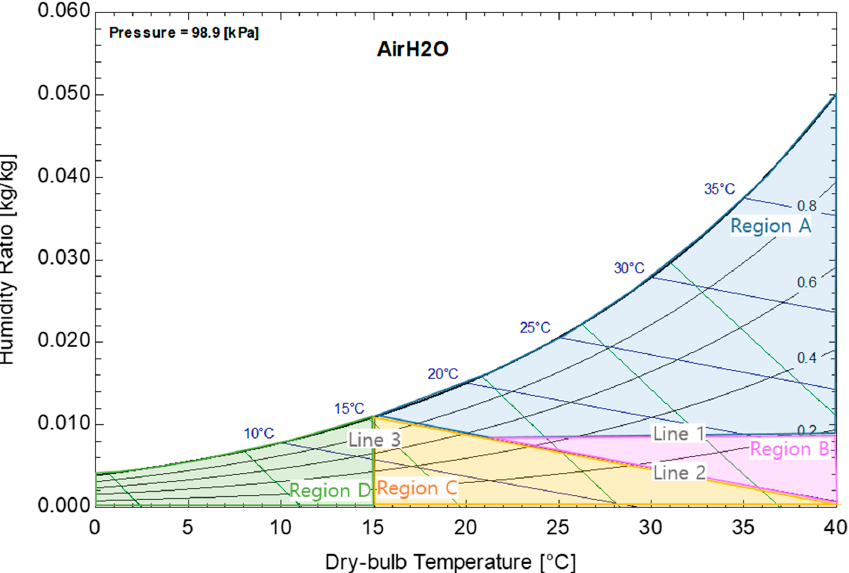
Figure 3. Operation modes of the LDIDECOA on psychometric chart.